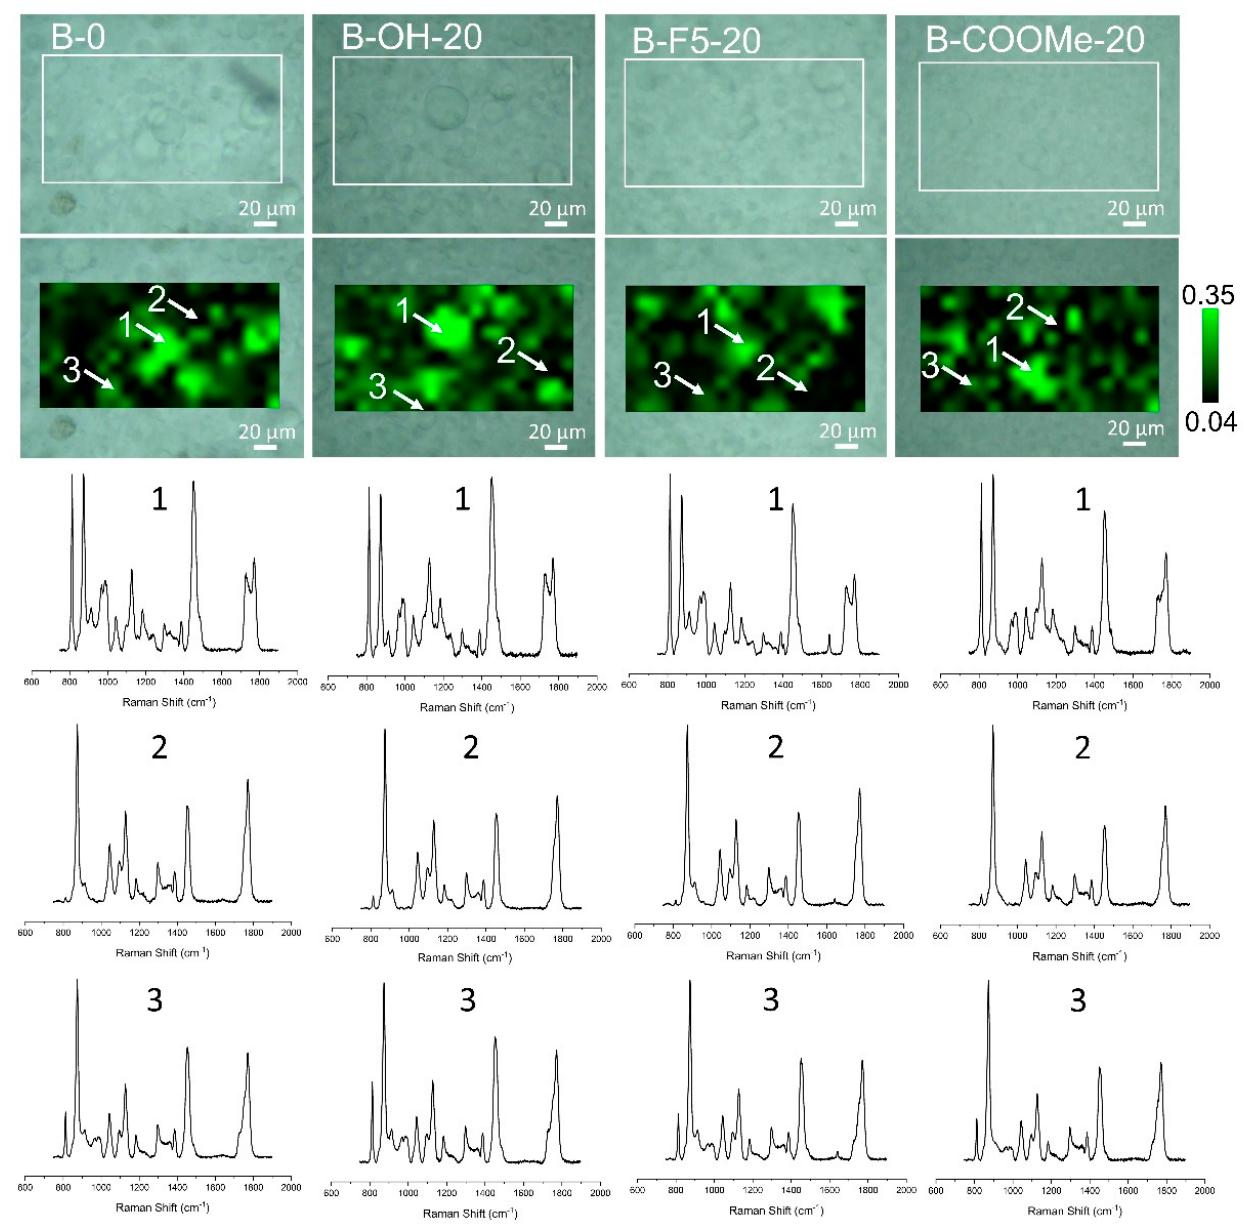
Figure 7. Raman maps of PLA/PMMA and ternary blends with 2 wt.% content of LPSQ-R illustrating distribution of PMMA in the blends (with corresponding optical micrographs in the background) and spectra of selected regions.